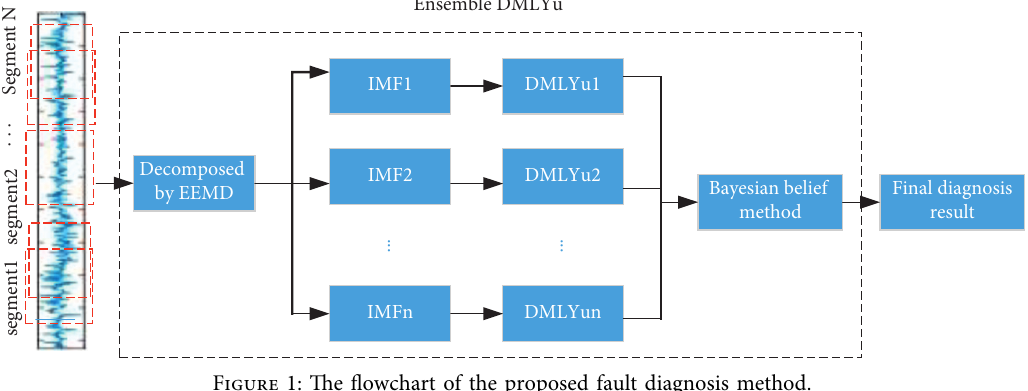
Figure 1: The flowchart of the proposed fault diagnosis